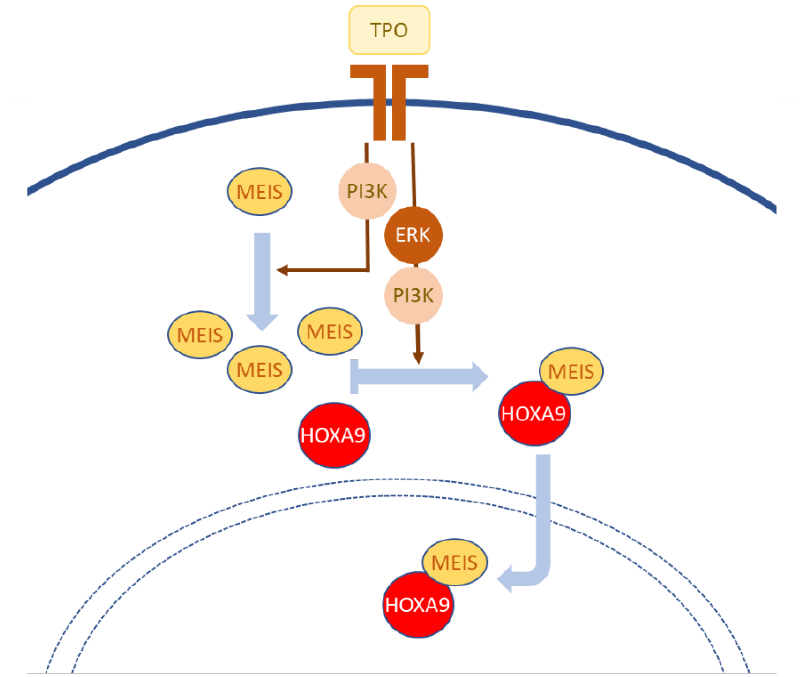
Figure 1. The nuclear translocation of HOXA9 in hematopoietic cells is stimulated by Thrombopoietin (TPO) and relies on its interaction with MEIS. TPO stimulates the expression of MEIS and abundance of MEIS protein, and also promotes the HOXA9–MEIS interaction and the nuclear localization of the HOXA9–MEIS complex. The enhancement of MEIS expression mediated by TPO relies on PI3K signaling. The formation of the HOXA9–MEIS complex and its nuclear entry involves both ERK and PI3K activities (see text for details)